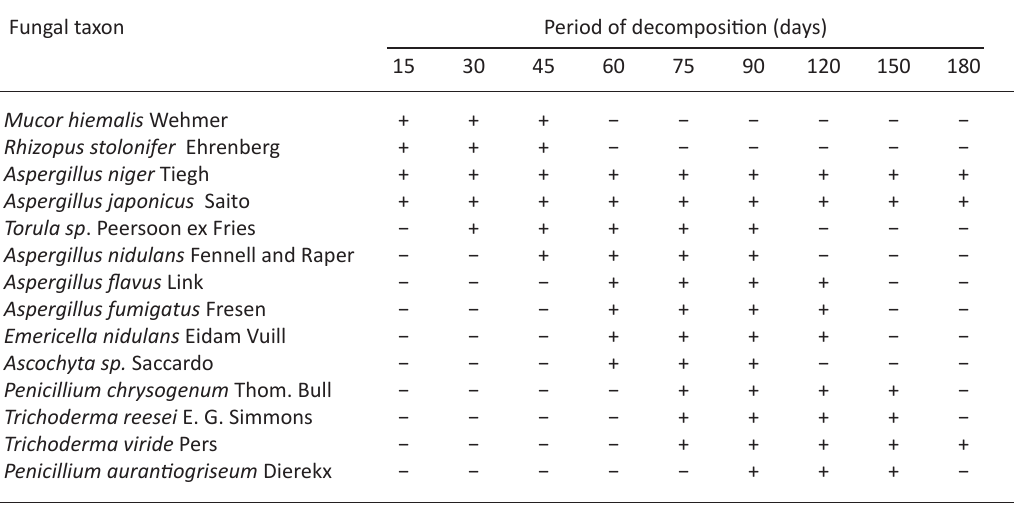
Table 1. Fungi identified associated with the litter of Acacia catechu in the forests of Datia district in order to appearance Fungal taxon Period of decomposition (days)